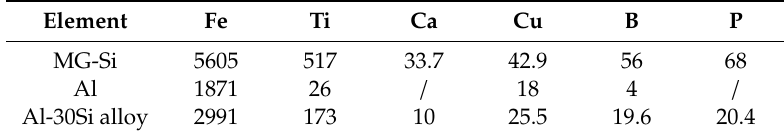
Table 1. The content of impurity in the raw materials